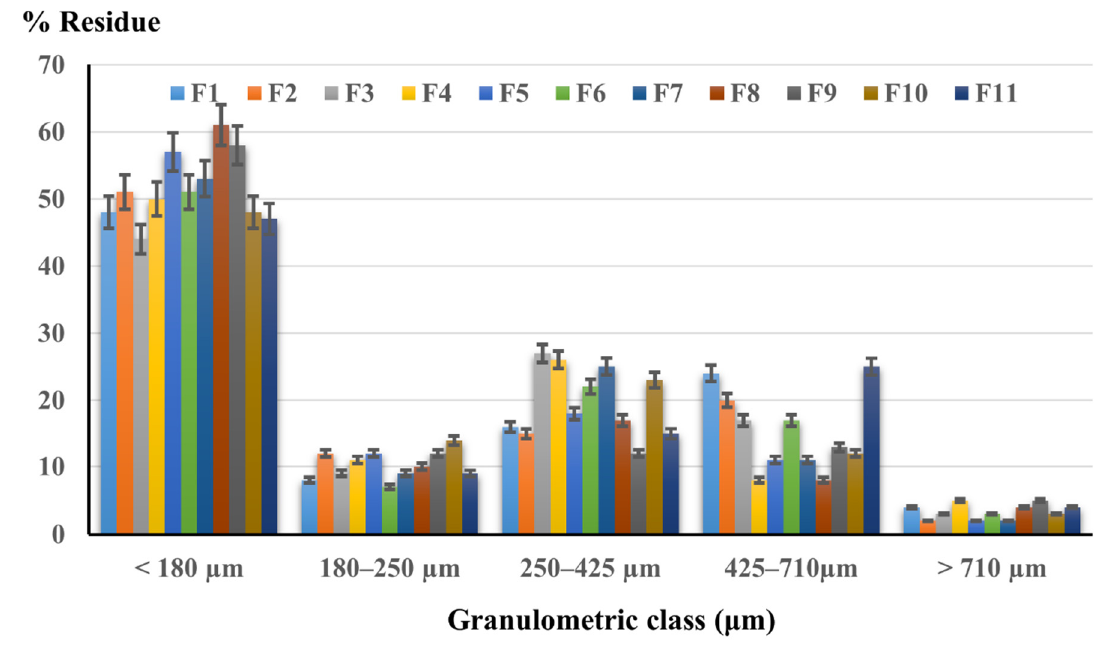
Figure 8. Particle size distribution for direct compression powders.